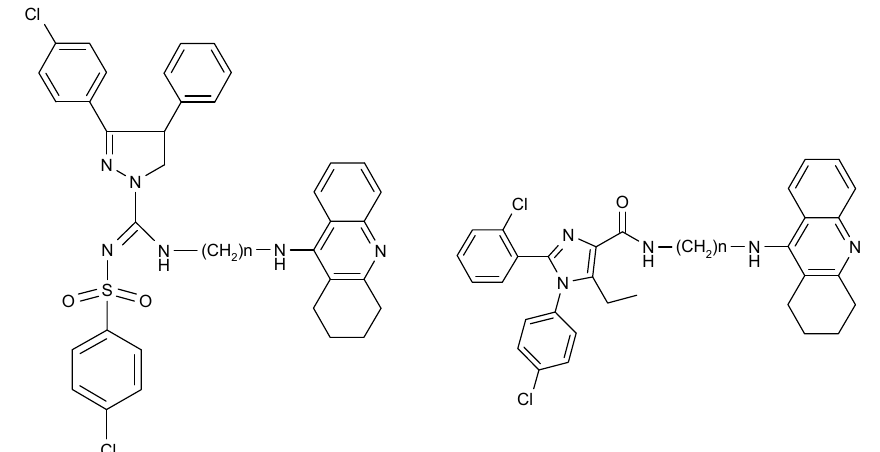
receptor antagonists 118–121 1